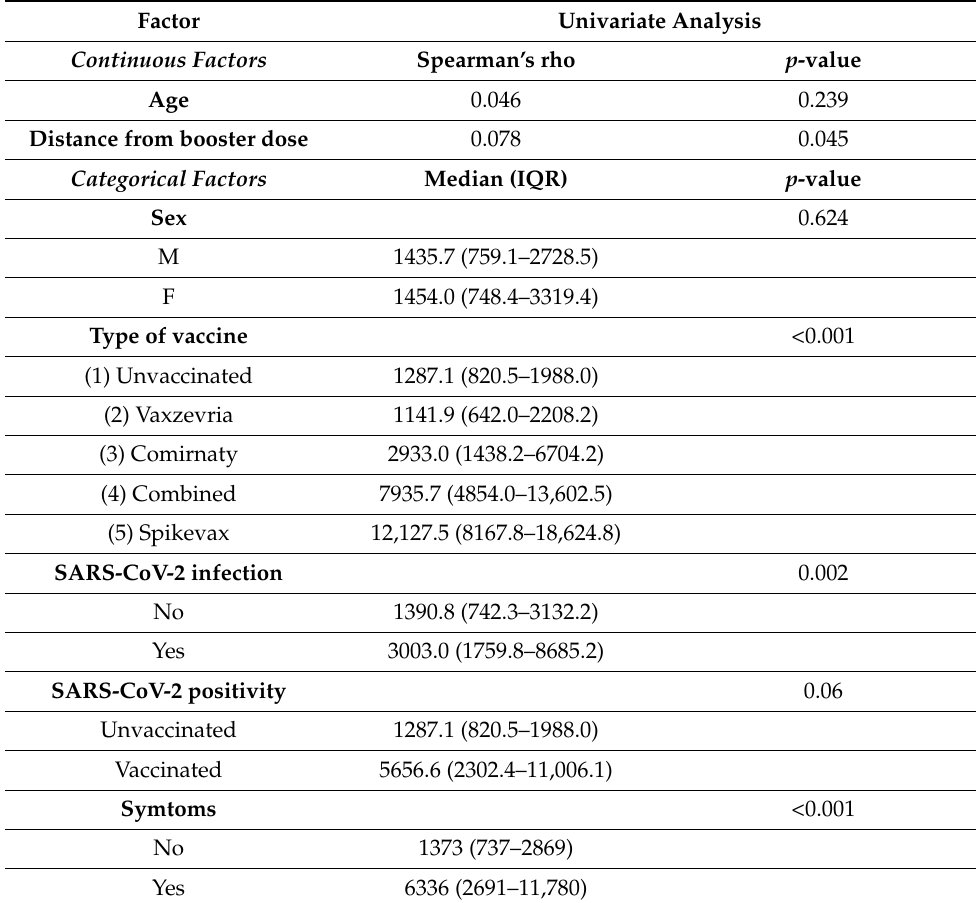
Table 2. Univariate analysis of the factors influencing “anti SARS-CoV-2 antibody titer”, expressed in